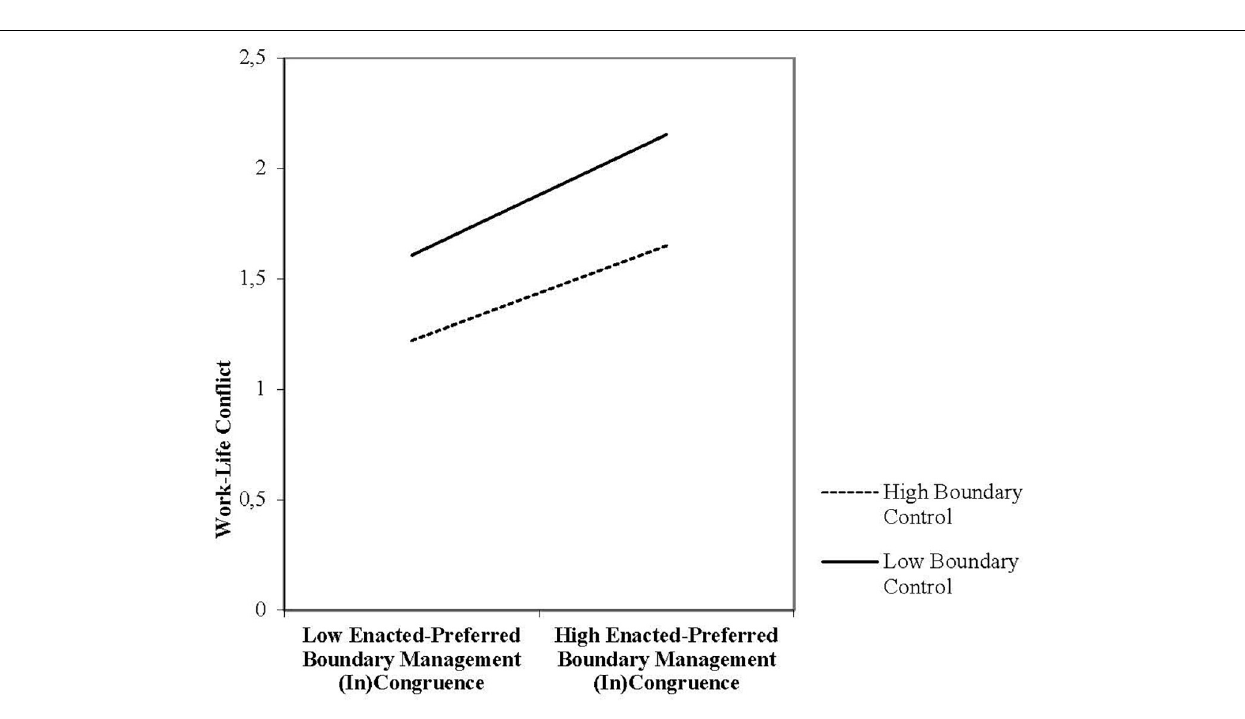
Frontiers in Psychology |